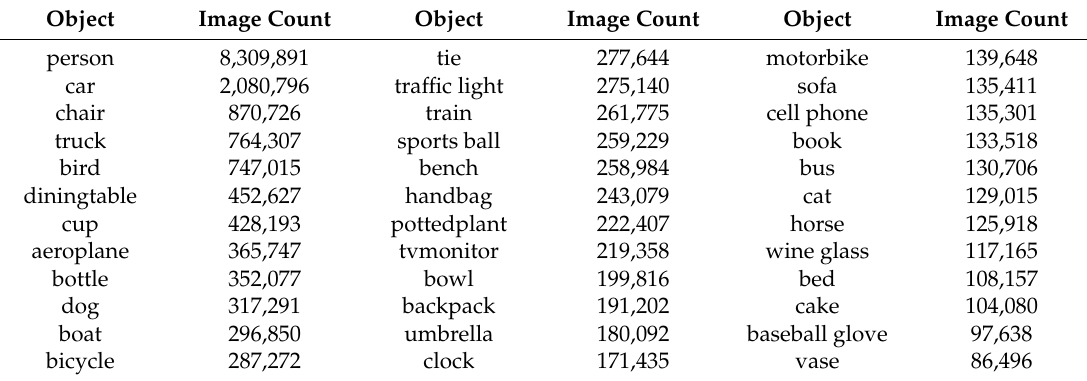
Table 1. The number of images that contain at least one of the top 48 detected